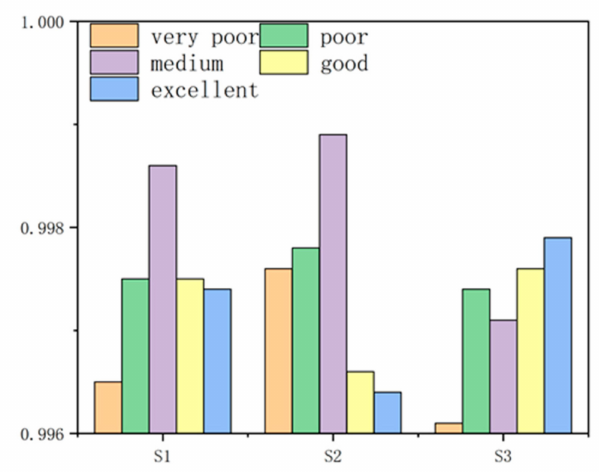
Figure 4. The weighted closeness of the three IEGES ( S Taking S 3 as an example of normalization, and calculate the eigenvalues of S 3